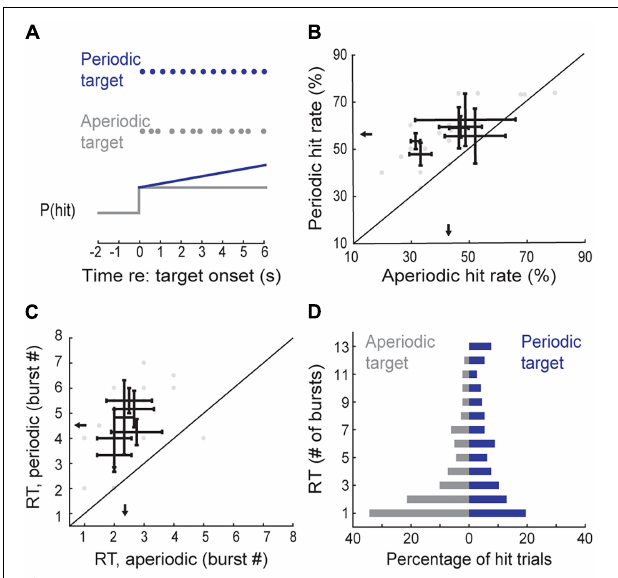
FIGURE 4 | Temporal regularity enhances the perceptual salience of a repeated target. (A) Top , schematic of periodic and aperiodic target presentation. Bottom , hypothesized “build-up” of detection probability based on temporal regularity. (B) Hit rates for interleaved periodic and aperiodic targets presented at a fixed contrast (30 dB SNR). Data from individual sessions are shown as gray circles. Black lines represent the mean ± SEM hit rates for each mouse. Arrows indicate group means. (C) Reaction times, in number of bursts, plotted as in panel (B) . (D) Histograms of reaction times, pooled across all session and subjects, for periodic and aperiodic trains of target